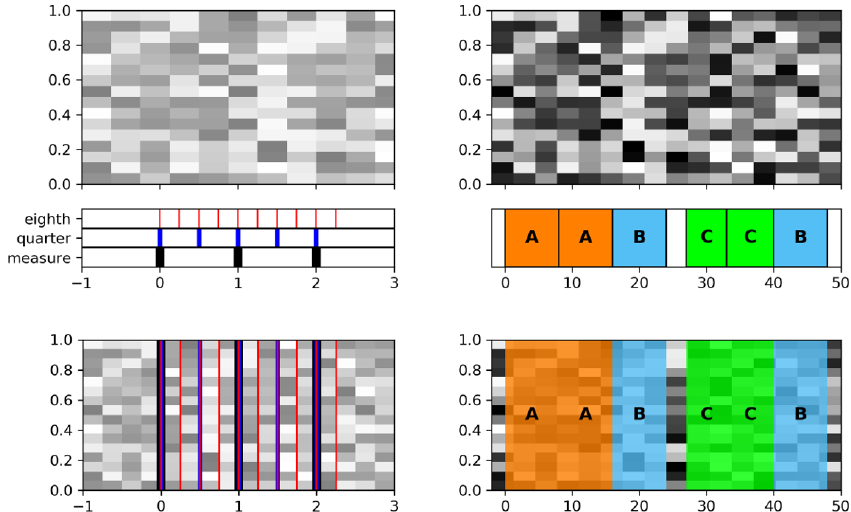
Figure 3. Examples for visualizing annotations of time positions ( left part) and segments ( right part), which may be interlinked ( upper part) and superimposed ( lower part) with feature representations (shown as gray-scale matrix